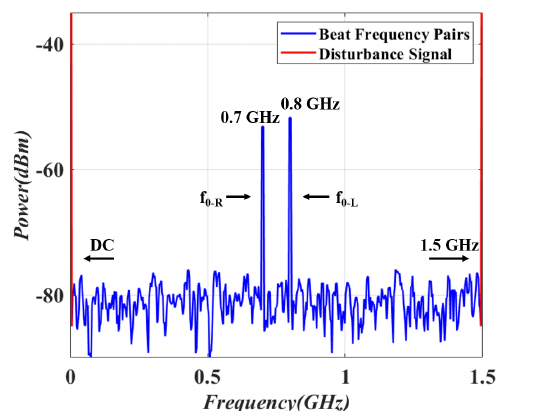
Figure 8. Measurement result using a single-tone signal, where f 0 = 8.3 GHz.